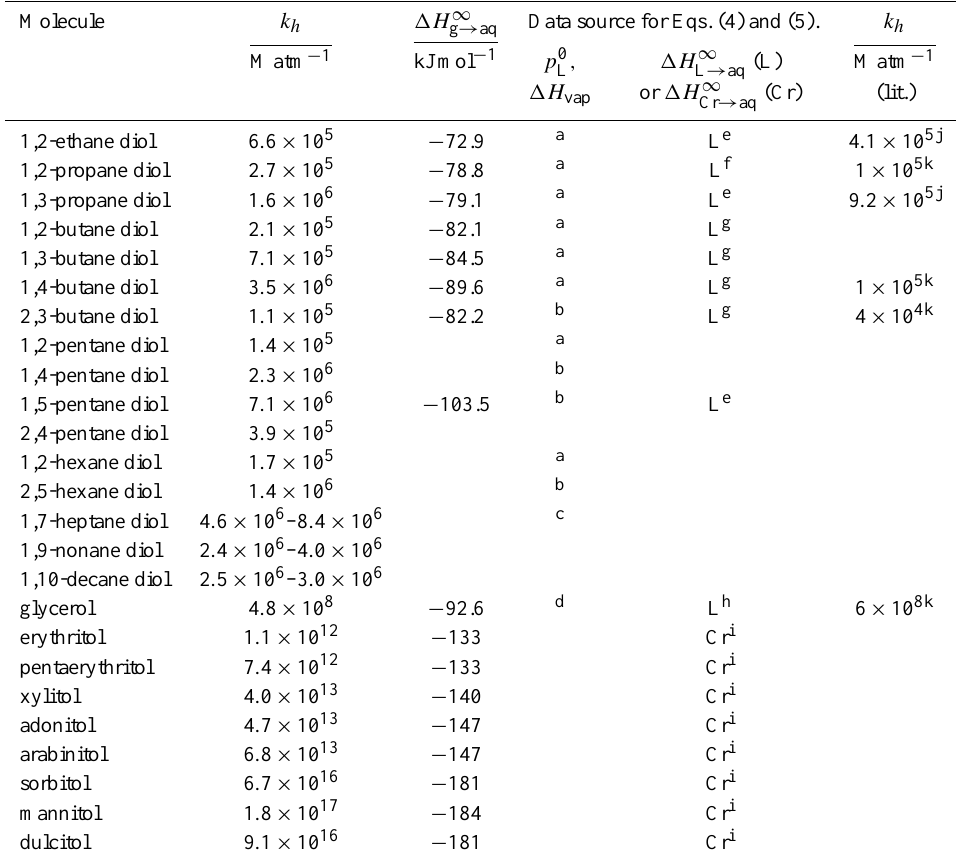
Table 5. Henry’s law constants and gas dissolution enthalpies at 298.15K for the polyols considered in this work, from Eqs. (4, 5, 8, 10). γ ∞ s is taken from Table 2, p 0 ,(cid:49)H sub from Table 3 and γ ∞ s /γ sat s from Table 4. Cr Molecule k h (cid:49)H ∞ g → aq Data source for Eqs. (4) and (5). k h Matm −